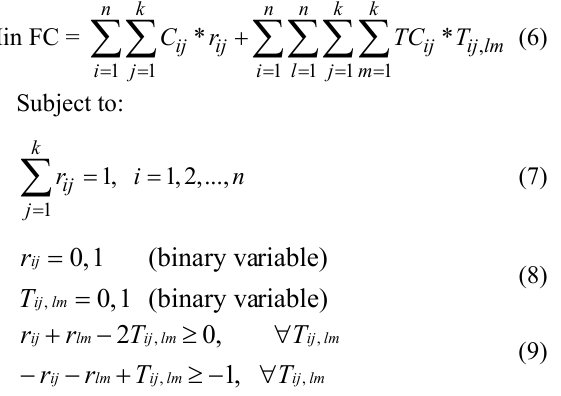
represents an average increment of the value of the final resource systems in 5.5%, between a range of a minimal of 0% and a maximum of